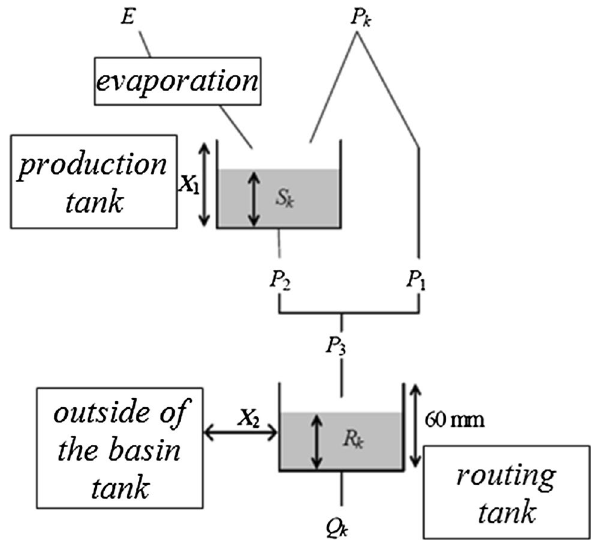
Fig. 2 Structure diagram of the GR2M model (Bouanani et al. 2015)